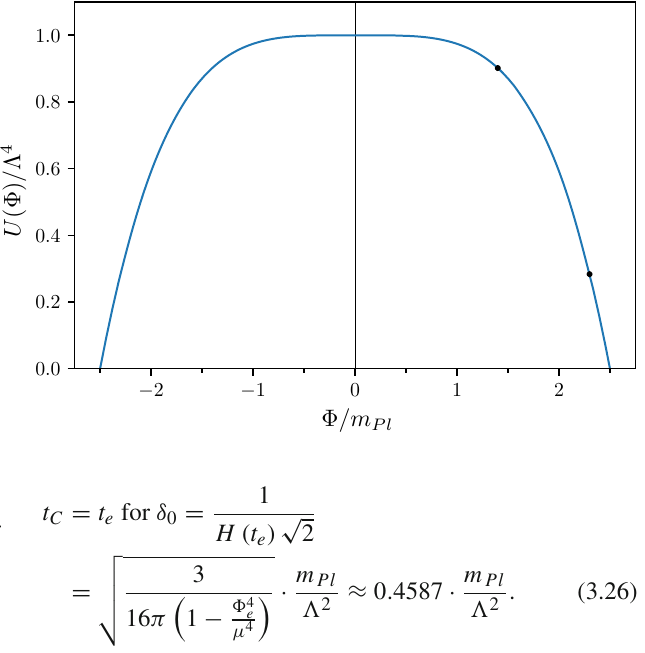
Fig. 4 Inflaton potential U ((cid:9)) in the “hilltop” model. Black dots correspond to (cid:9) = 1 . 4 m i Pl and